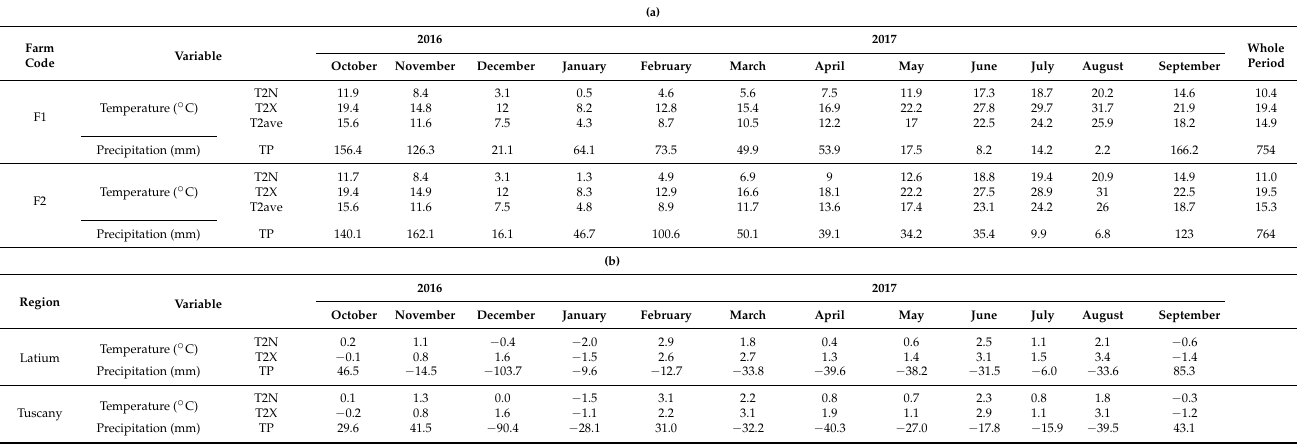
Precipitation(mm)